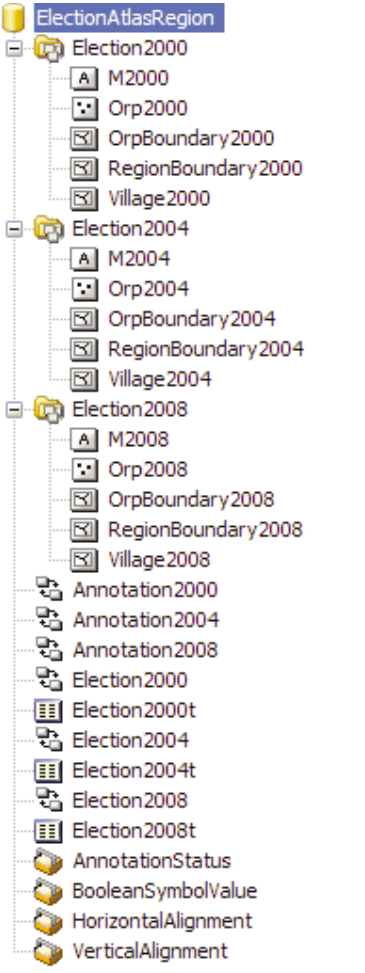
Fig. 5. Portion of valid votes in villages for the ODS party (2008)